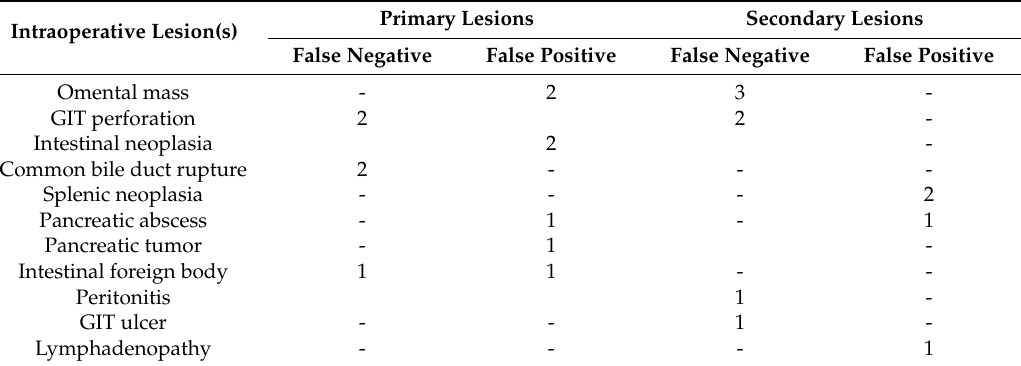
Table 4. Lesions misinterpreted by pre-operative abdominal ultrasound, using surgery as “criterion